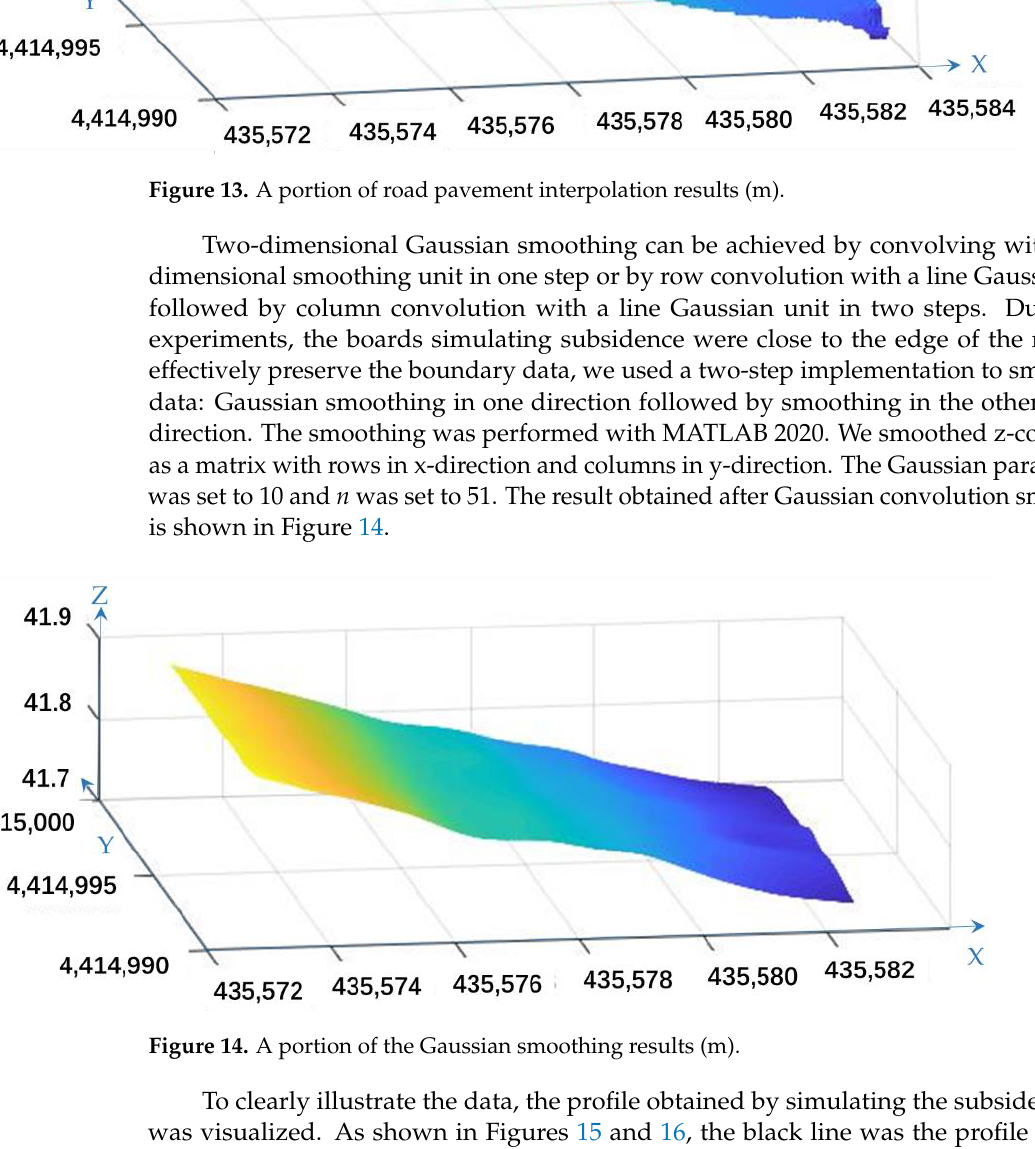
Figure 13. A portion of road pavement interpolation results (m).